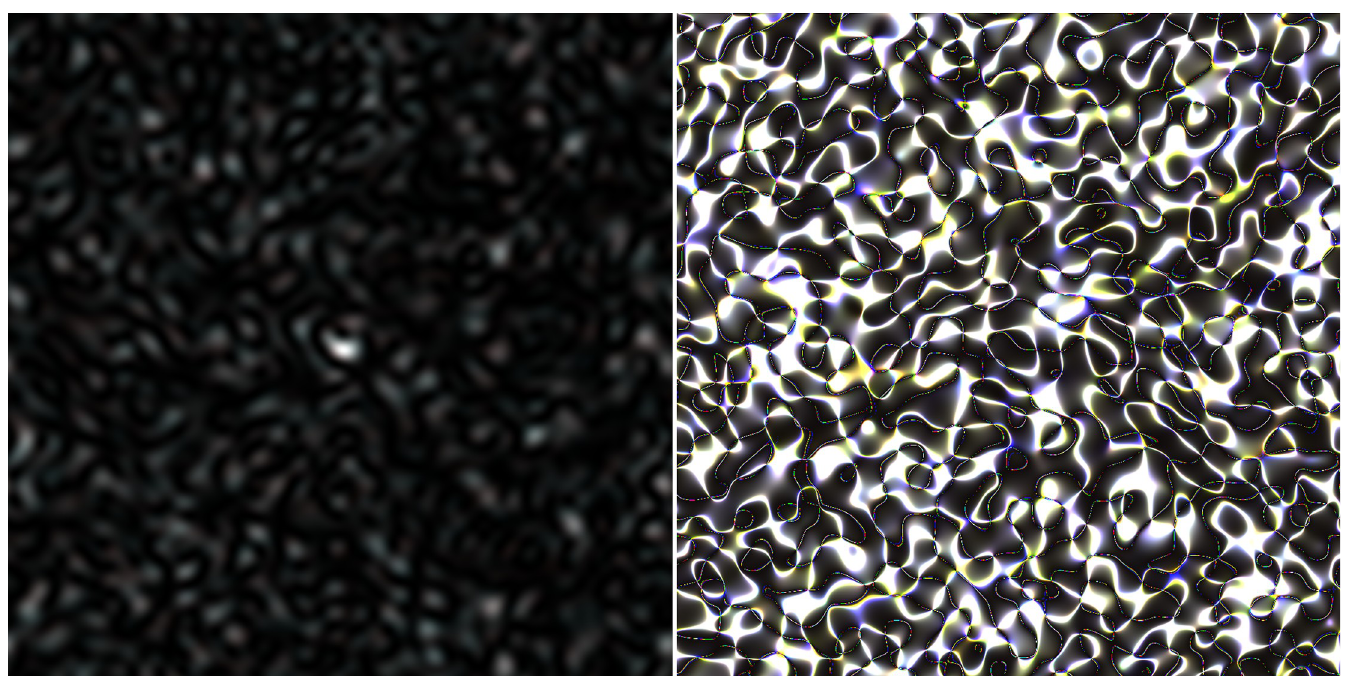
Fig 6. Colored images of GB-speckles, generated for full concatenated nucleotide sequence, combined together from a set of seven genes of house-keepings. (a) Case of raw GB-speckles. (b) Phase map of raw GB-speckles.